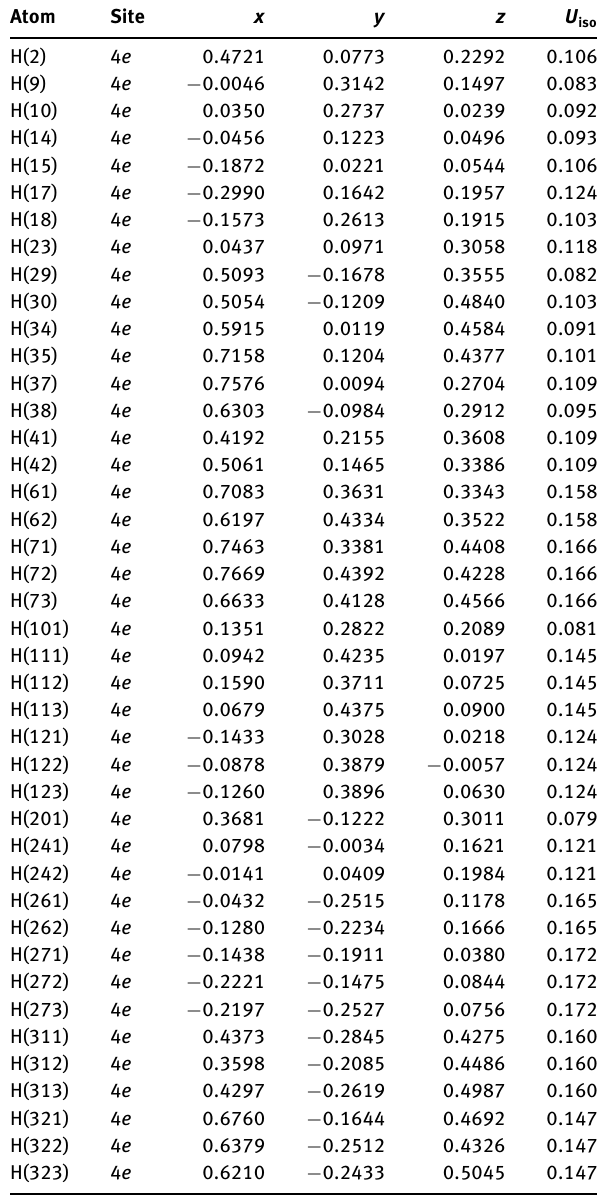
Table 2: Fractional atomic coordinates and isotropic or equivalent isotropic displacement parameters (Å 2